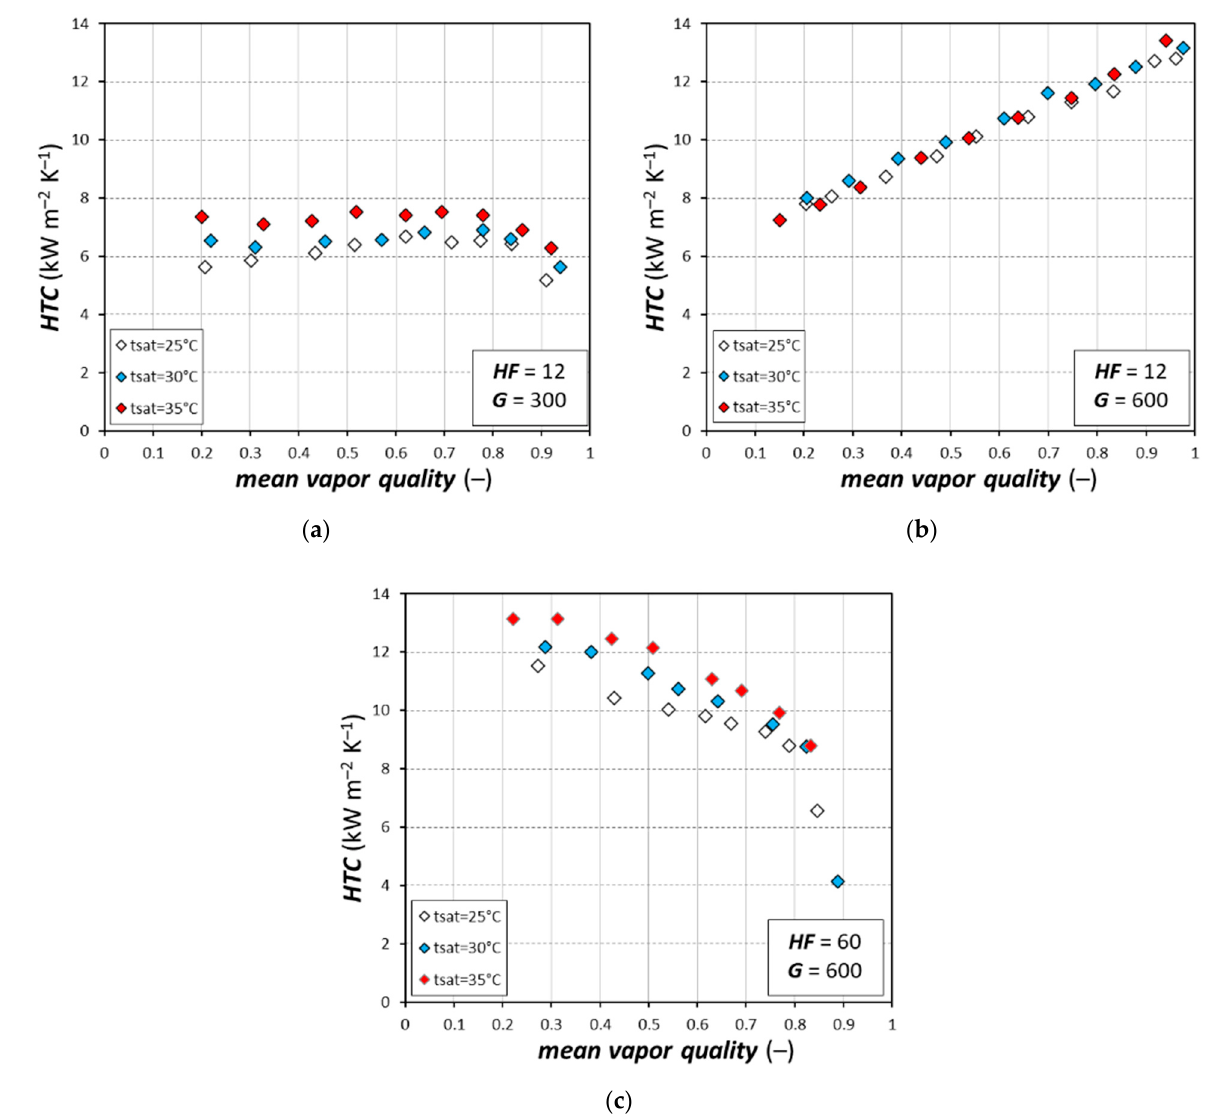
Figure 5. Heat transfer coefficient versus mean vapor quality. ( a ) Data at G = 300 kg m − 2 s − 1 , HF = 12 kW m − 2 ; ( b ) data at G = 600 kg m − 2 s − 1 , HF = 12 kW m − 2 ; ( c ) data at G = 600 kg m − 2 s − 1 , HF = 60 kW m − 2 .